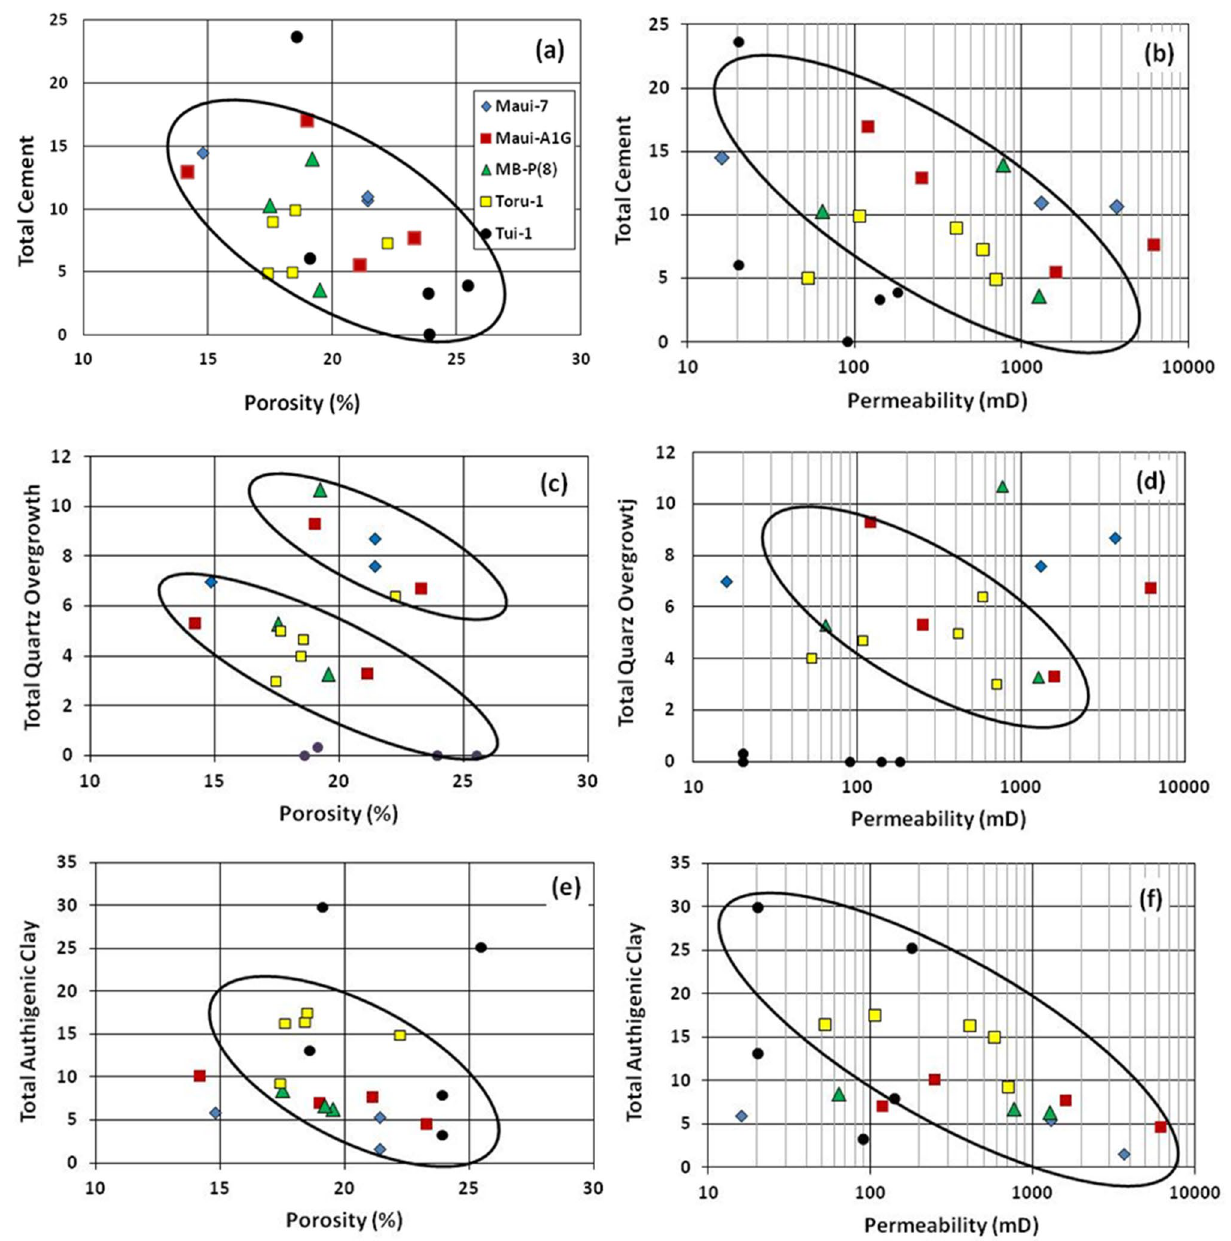
Fig. 8 Porosity and permeability graphs in relation to total cement, total quartz overgrowth and total authigenic clay for the selected Kaimiro Formation